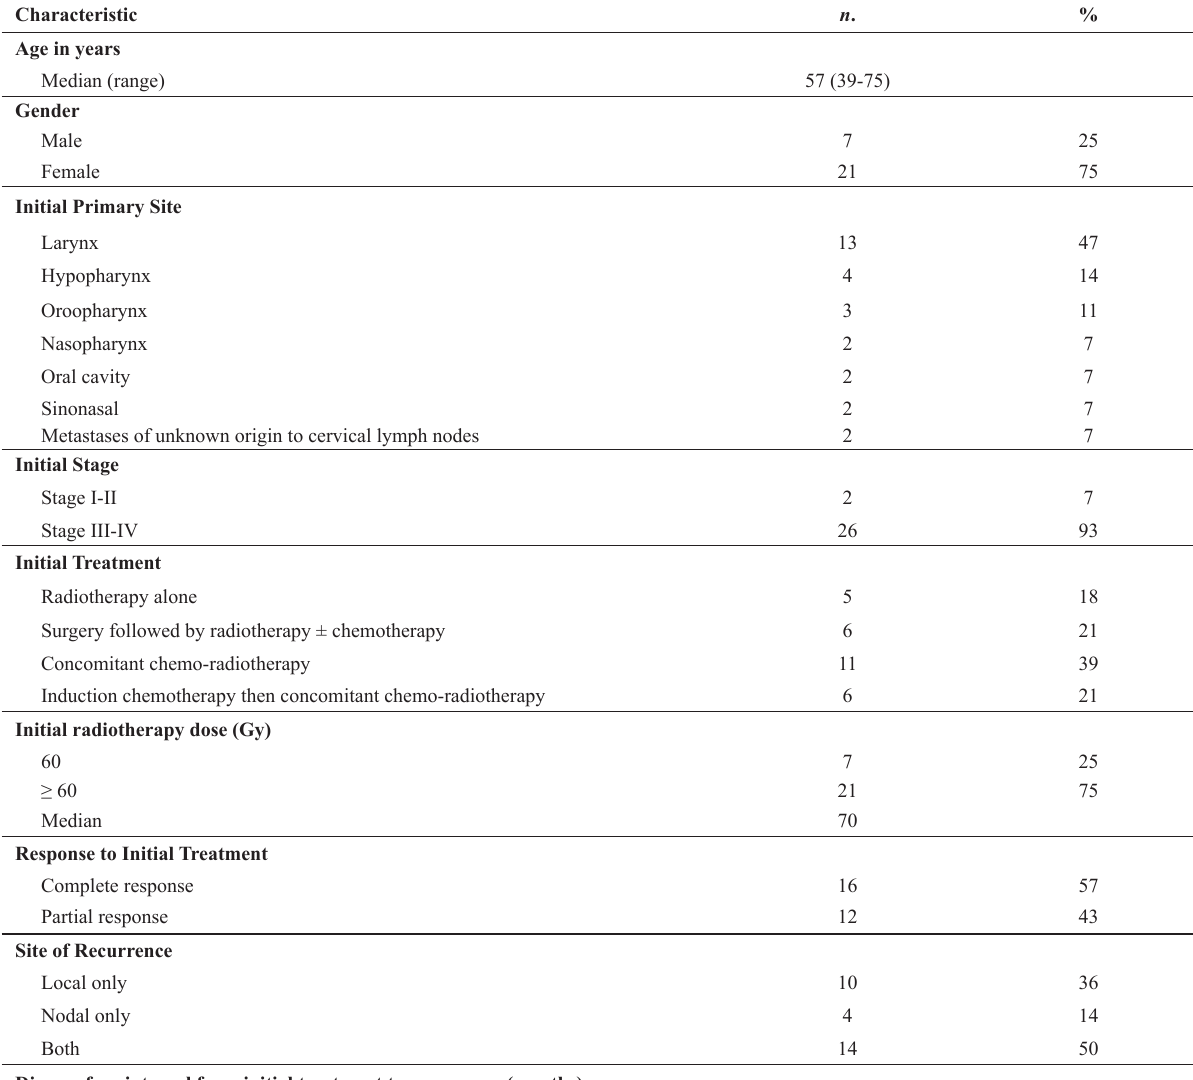
Figure 1: Kaplan–Meier survival curve of progression free survival Table 1: Patients’